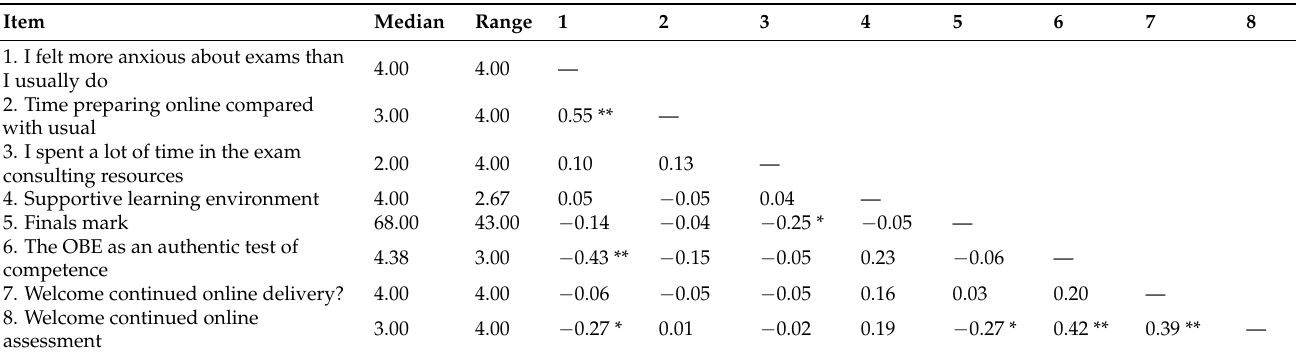
Table 1. Summary of descriptive statistics and Spearman’s correlations ( r s ) examining learners’ perceptions of OBE and finals assessment